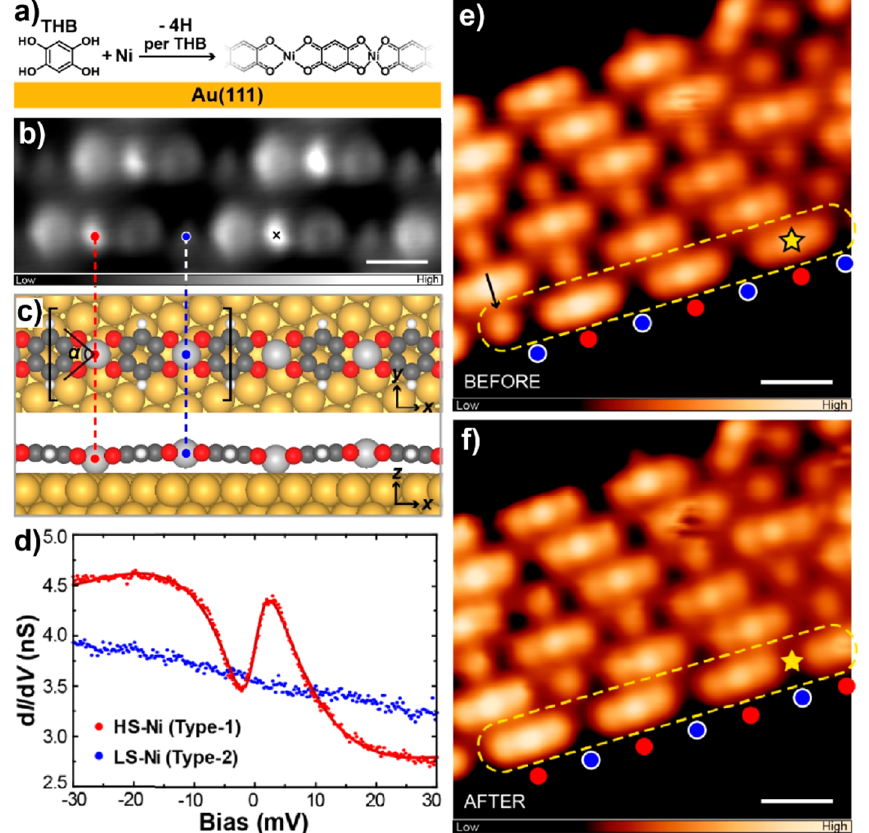
Figure 7. ( a ) Schematic illustration of the coordination reaction between tetrahydroxybenzene (THB) and Ni on Au(111). ( b ) STM image of the coordination chains. ( c ) Optimized models of the coordination chain. ( d ) d I / d V spectra acquired at a HS-Ni and a LS-Ni, respectively. STM images of the coordination chains ( e ) before and ( f ) after the tip-induced collective switching within the marked chain. Adapted from [78], with permission from American Chemical Society, 2020.